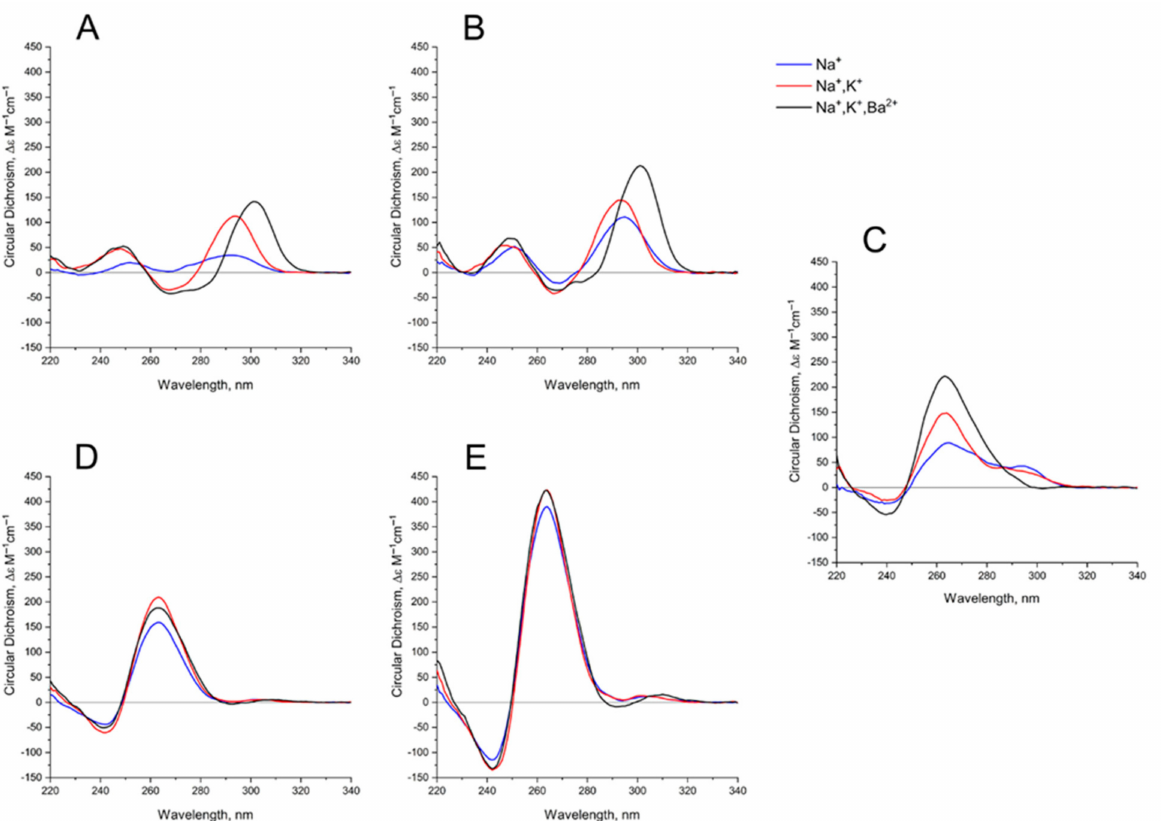
Figure 3. CD spectra GQs under study: in the buffer A (140 mM NaCl; (Na + ), blue), in the buffer B (140 mM NaCl, 10 mM KCl; (Na + , K + ), red), in the buffer C (140 mM NaCl, 10 mM KCl, 5 mM BaCl 2 ; (Na + , K + , Ba 2+ ), black) at 20 ◦ C: ( A ) HD1, ( B ) bi-HD1, ( C ) AS1411, ( D ) AID-1-T, ( E ) bi-(AID-1-T).